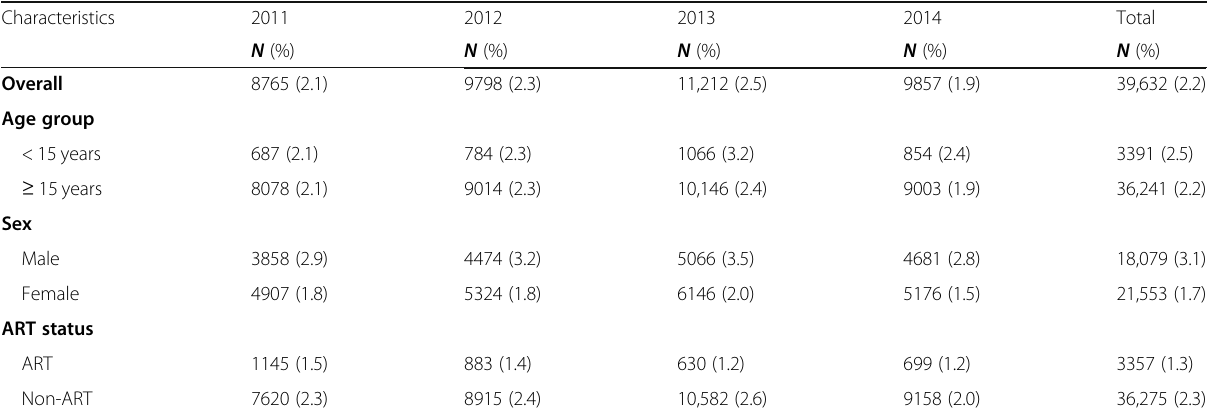
Table 2 Prevalence of TB among individuals enrolled in HIV care, treatment, and support program in Tanzania from 2011 to 2014 Characteristics